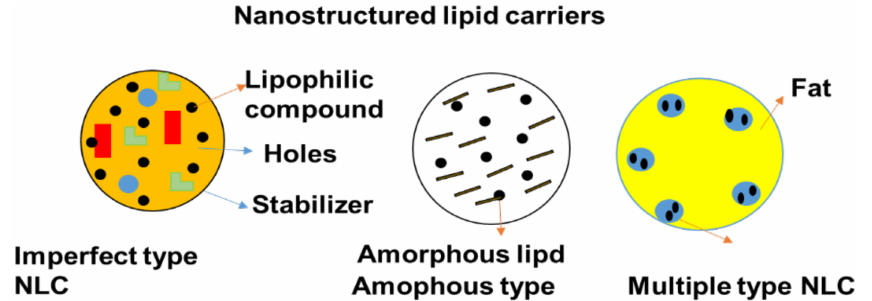
Figure 7. Schematic diagram of nanostructured lipid